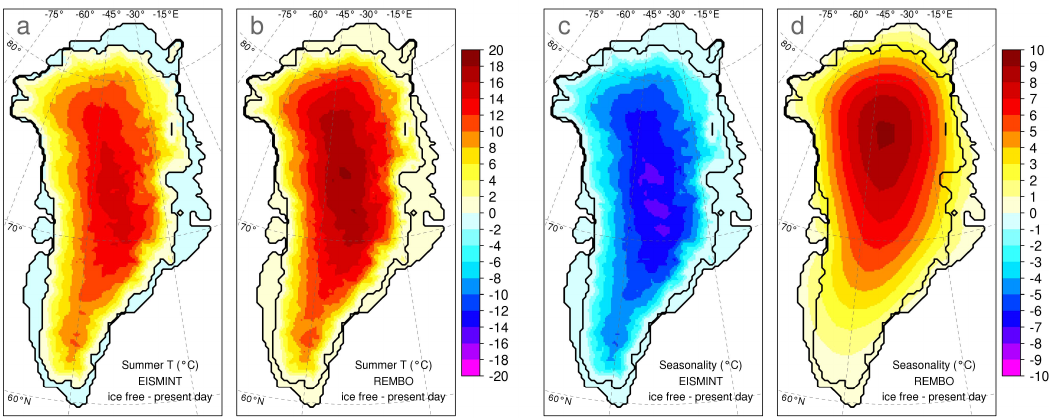
Fig. 8. Summer (JJA) temperatures for ice-free, uplifted bedrock topography minus those of present-day, ice-covered conditions for (a) the EISMINT temperature parameterization and (b) REMBO. Difference in seasonality (June-July-August temperature minus December- January-February temperature) for the uplifted, ice-free topography compared to present-day, ice-covered conditions using (c) the EISMINT temperature parameterization and (d) REMBO.